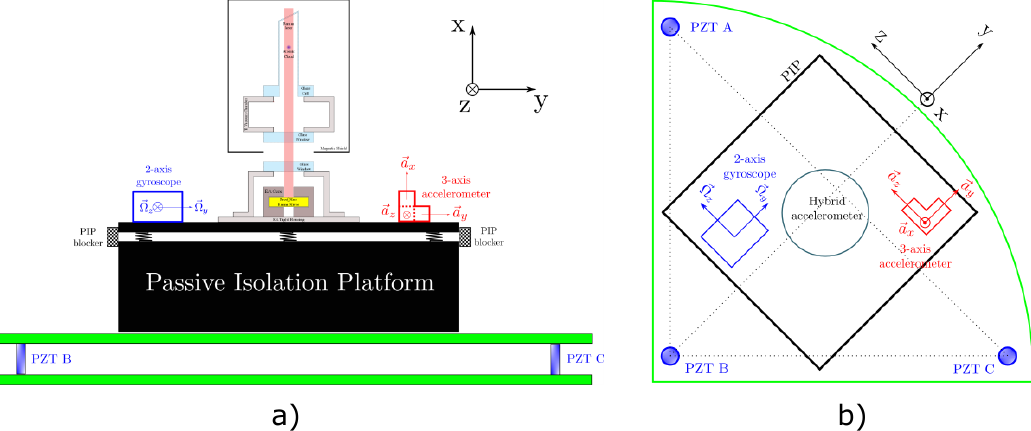
Figure 8. Representation of the experimental setup (( a ) side view and ( b ) top view) used to study rotation impact on the CAI and to demonstrate rotation compensation through EA proof-mass actuation. The dimensions are not to scale. The distance between PZT A–PZT B and PZT B–PZT C is 56